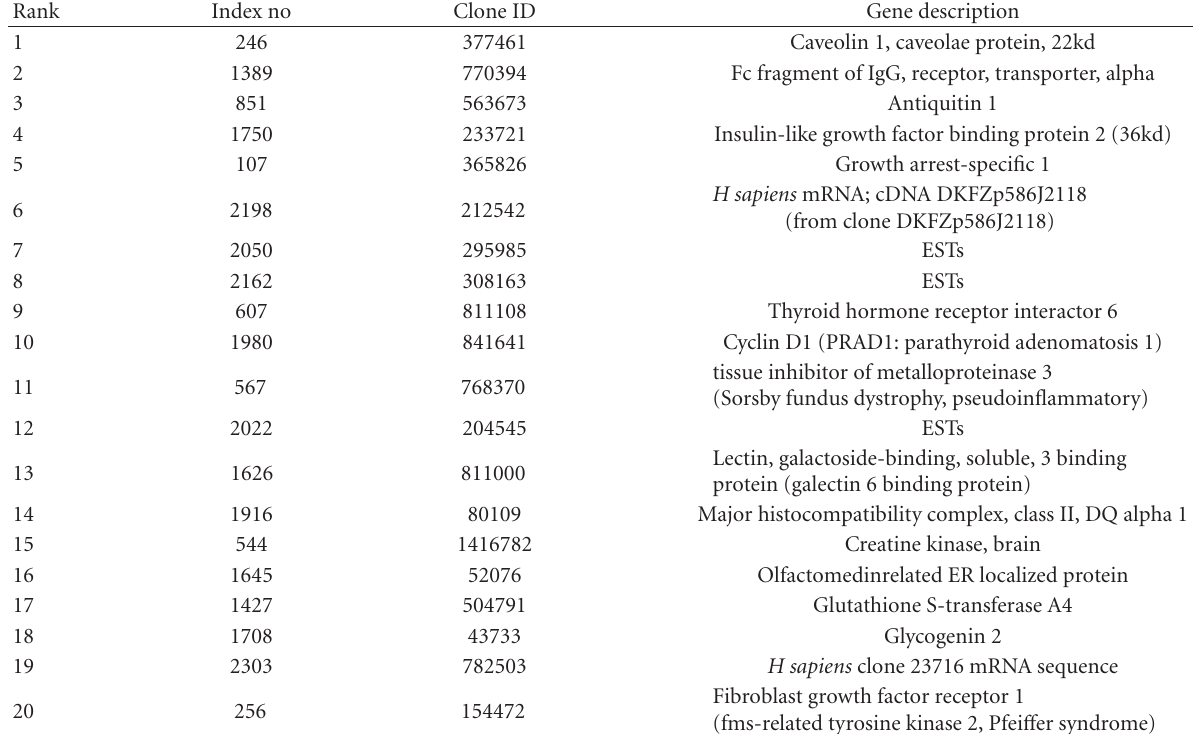
Table 5. A part of the strongest genes selected in small round blue-cell tumors dataset (the first row of genes in Table 4). Rank